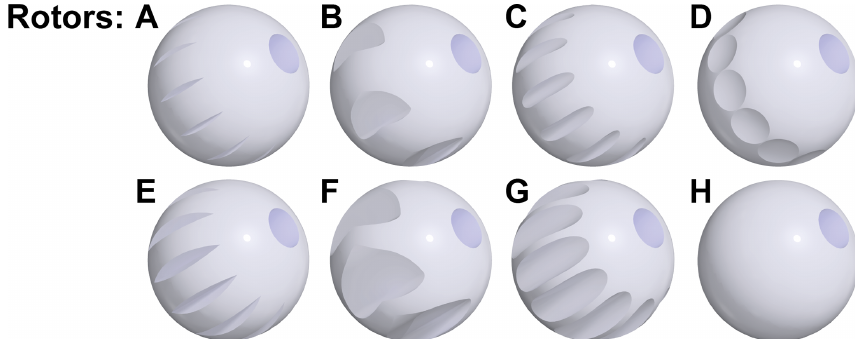
Figure 2. 9.5mm spherical rotor turbine groove designs. Each rotor has a 2.54mm diameter through hole. A: 12 60 ◦ notched grooves, 0.35mm depth (as described previously by Chen et al., 2018). B: 6 impeller-style grooves, 0.25mm radius. C: 12 circular 0.25mm radius grooves. D: 12 dimpled grooves, 4.75mm radius dimples. E: 12 60 ◦ notched grooves, 0.85mm depth. F: 6 impeller-style grooves, 0.5mm radius. G: 12 circular 0.5mm radius grooves. H: smooth surface, no flutes